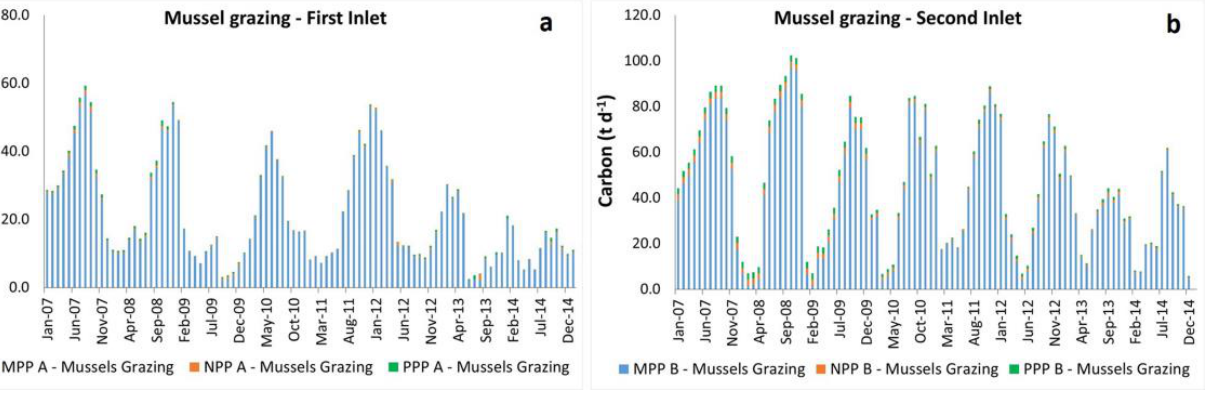
Figure 8. Simulation of mussel grazing on phytoplankton fractions (MPP, NPP and PPP) in terms of Carbon (t d − 1 ). ( a )FI and ( b ) SI.